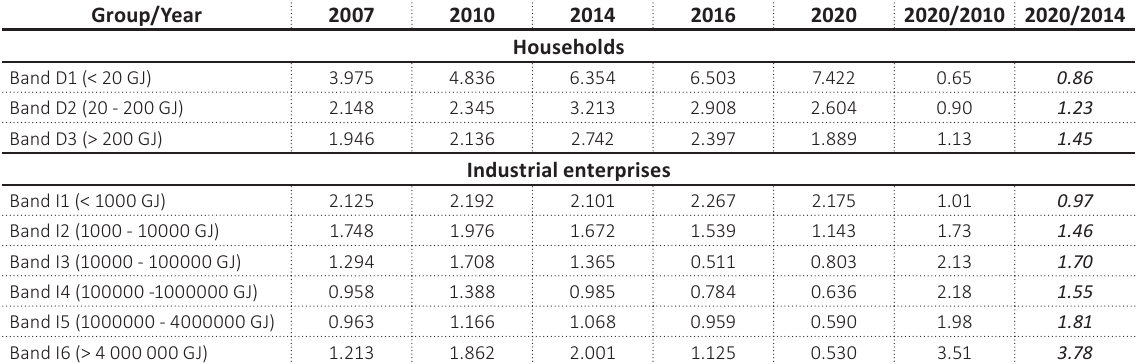
Table 2. Quantitative parameters of the price of gas convergence,